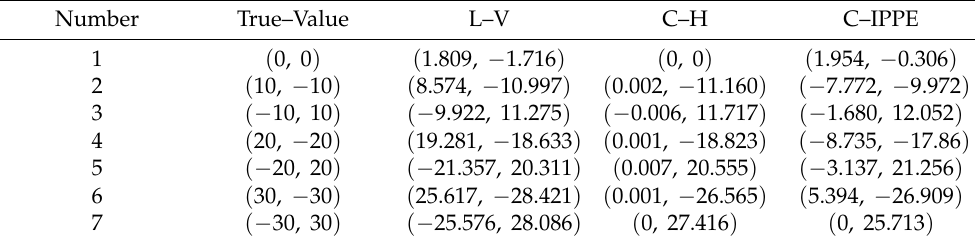
Table 4. Measurement results of rotation angle ( θ , ϕ ) around the Y C axis and then around then Z C